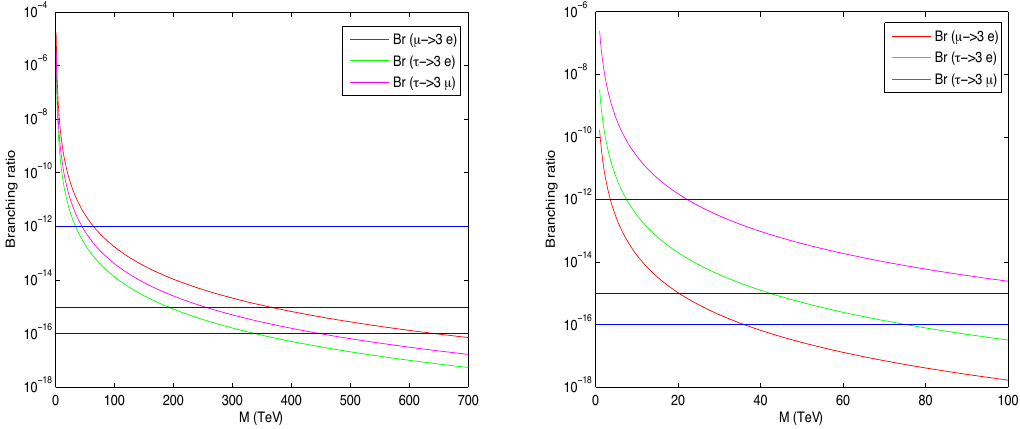
Figure 1 . Branching ratios Br( (cid:22) ! 3 e ), Br( (cid:28) ! 3 e ), and Br( (cid:28) ! 3 (cid:22) ) as functions of the new neutral gauge boson mass m Z 0 (cid:17) M , respectively. The three blue horizon-lines correspond